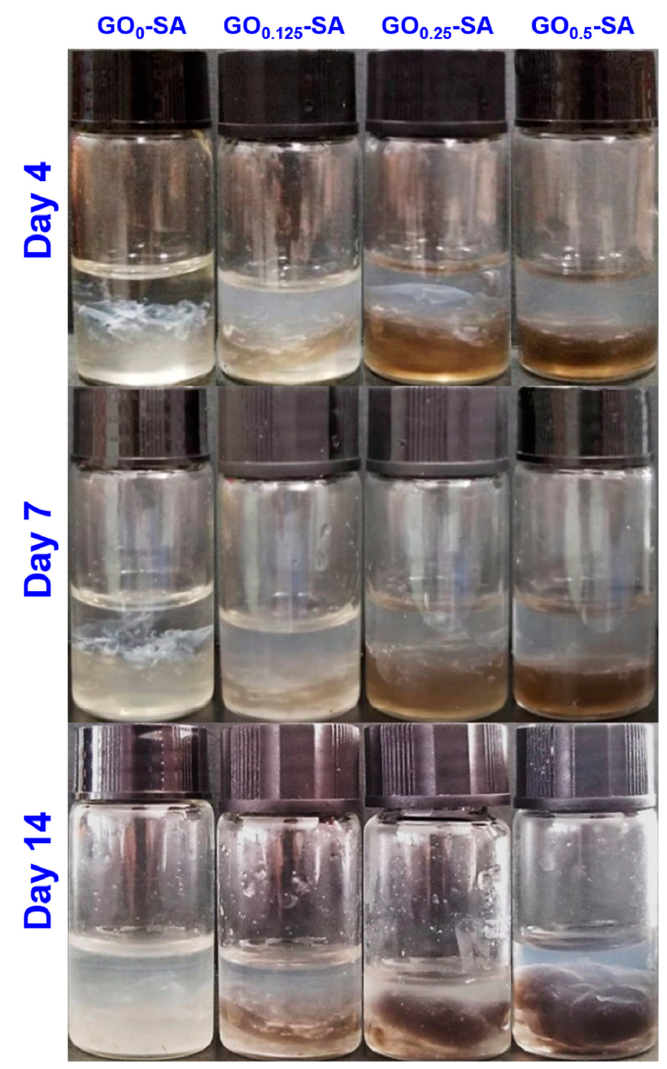
Figure 4. Degradation of SA and GO-SA hydrogels in